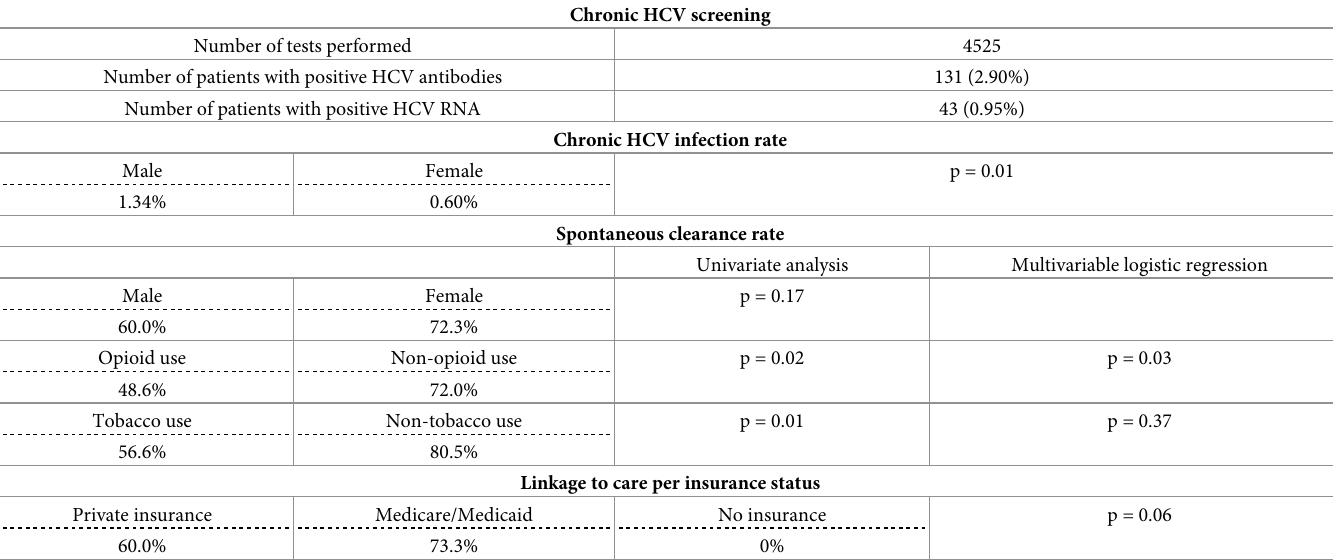
Table 1. Chronic HCV infection rate, spontaneous clearance rate, and LTC according to patient